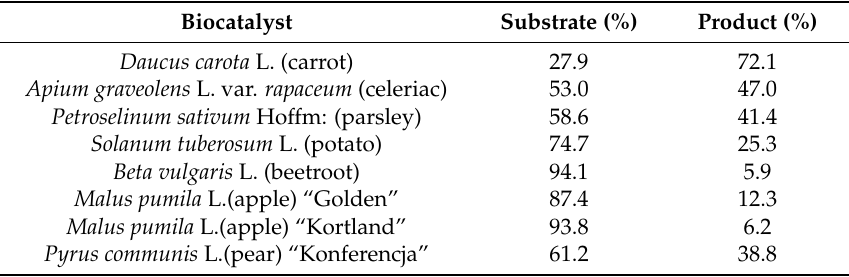
Table 3. Results of the (1 R , 4 R )-(+)-dihydrocarvone ( 2 ) biotransformation. Biocatalyst